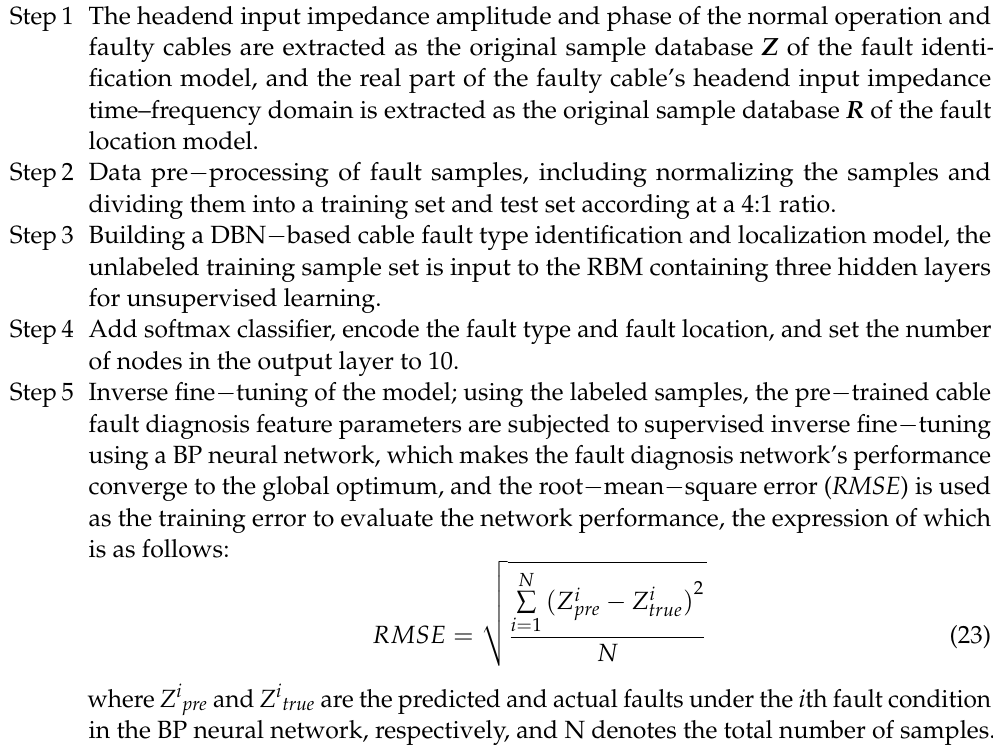
Table 1. R f values of different types of cable faults.